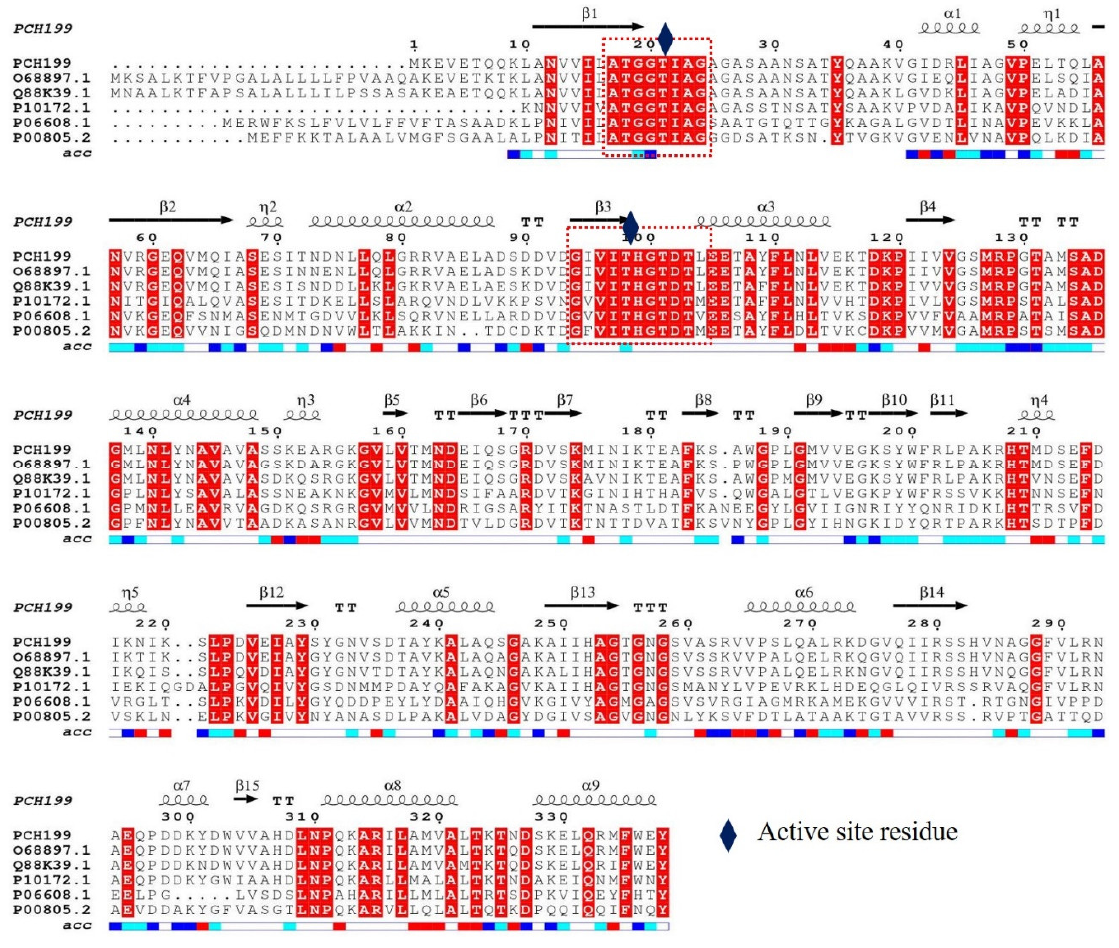
Figure 1. Multiple sequence alignment of Pg -ASNase II sequences using UniProt identifiers. Align- ment of L-ASNases was performed by using ClustalW and ESPript 3.0. ‘ α ’ represents α -helix; ‘ β ’ represents β -sheet; ‘ η ’ represents 3 10 helix; ‘TT’ represents strict β -turn; and ‘TTT’ represents strict α -turn. The secondary structure was observed from the 3D structure of Pseudomonas 7A glutaminase- asparaginase (PDB ID: 3PGA) and reported at the top. A 1014 bases (without signal sequence) Pg - asn II gene of Pseudomonas sp. PCH199